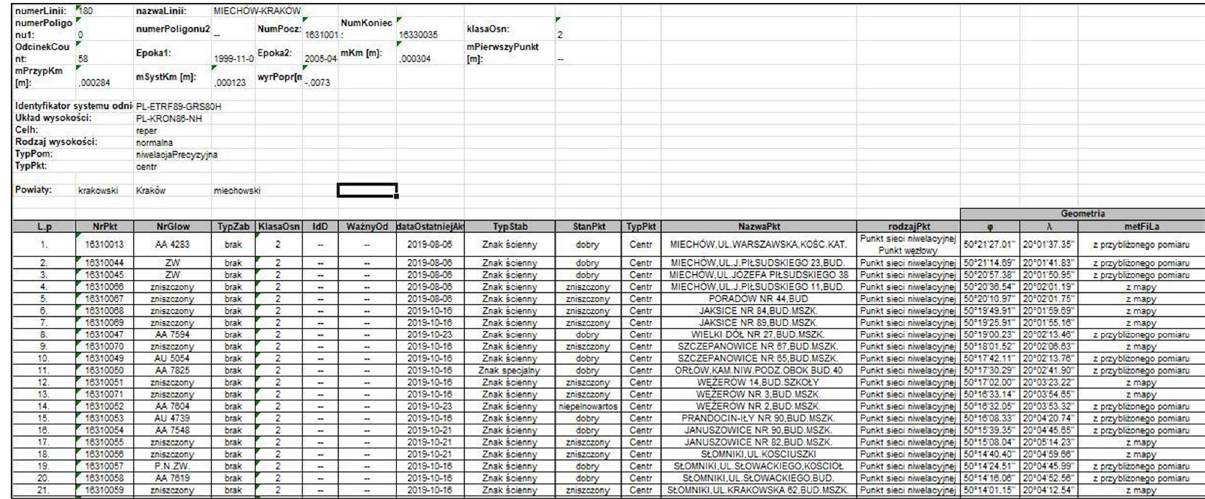
Figure 1: File with data on the vertical control network retrieved from Geoportal. Source: GUGiK